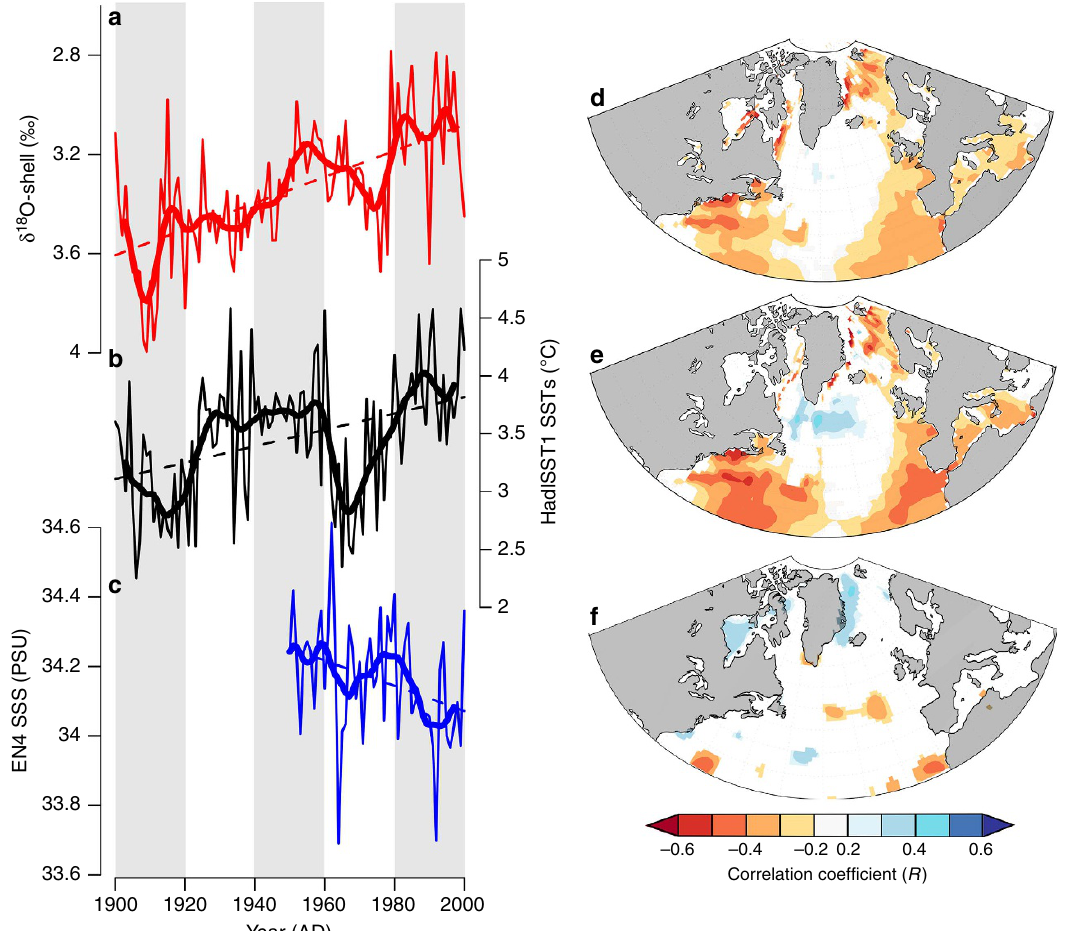
Figure 3 | Spatial and temporal examination of the d 18 O-shell data with instrumental oceanographic time series. ( a – c ) Plots of the annual (thin lines) and 10-year low-pass-filtered (thick lines) ( a ) d 18 O-shell, ( b ) HadISST1 gridded SST data and ( c ) EN4 gridded SSS. ( d , e ) Spatial correlations between the d 18 O-shell and HadISST1 SSTover ( d ) the growing season (March to October) and ( e ) the preceding winter (December to February). The correlations are calculated over the period 1870–2000. ( f ) Spatial correlations between the d 18 O-shell and the EN4 SSS gridded SSS data set. Correlations calculated over the period 1950–2000. All correlations shown are significant with a P o 0.1. Instrumental displayed in b , c are derived from a 10 (cid:2) by 20 (cid:2) grid box (65–75 (cid:2) N 10–30 (cid:2) W) north of Iceland. Spatial correlations generated using the KNMI climate explorer